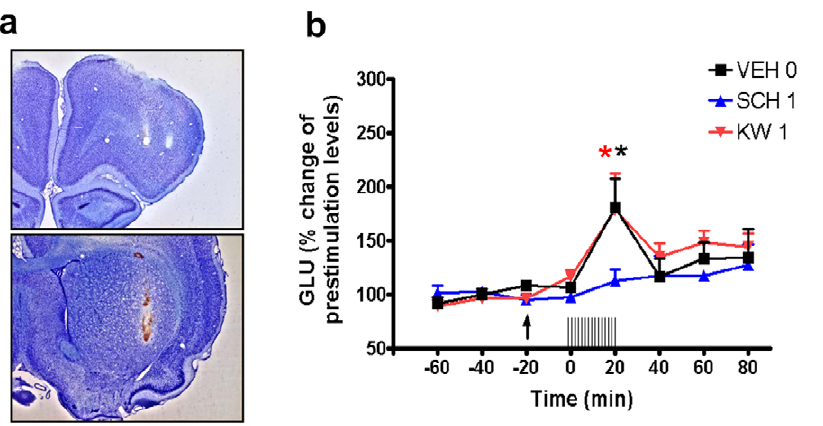
Figure 3. Blockade by A 2A R antagonists of striatal glutamate release induced by cortical electrical stimulation. (a) Representative coronal sections of a rat brain, stained with cresyl violet, showing the tracks left by the bipolar stimulation electrode in the orofacial area of the lateral agranular motor cortex (top) and by the microdialysis probe in the lateral striatum (bottom). (b) Effect of systemic administration of the A 2A R antagonists SCH-442416 and KW-6002 (1 mg/kg, i.p., in both cases) on the increase in glutamate extracellular levels in the lateral striatum induced by cortical electrical stimulation. Results are expressed as means 6 S.E.M. of percentage of the average of the three values before the stimulation (n=5– 7 per group). Time ‘0’ represents the values of the samples previous to the stimulation. The arrow indicates the time of systemic administration. The train of vertical lines represents the period of cortical stimulation. *: p , 0.05 compared to value of the last sample before the stimulation (repeated- measures ANOVA followed by Tukey’s test).